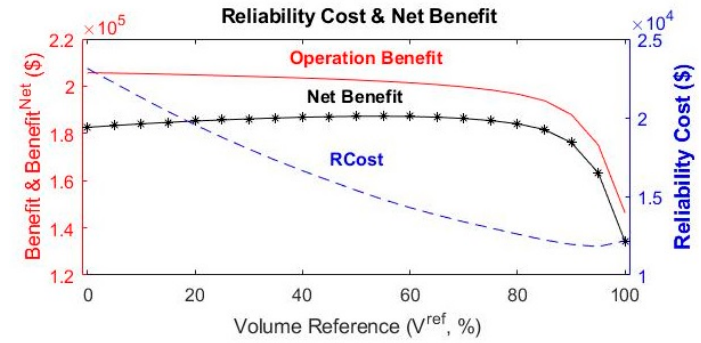
Figure 15. Net Benefit result of HPP. Table 3. Detailed Result of Figure 15.